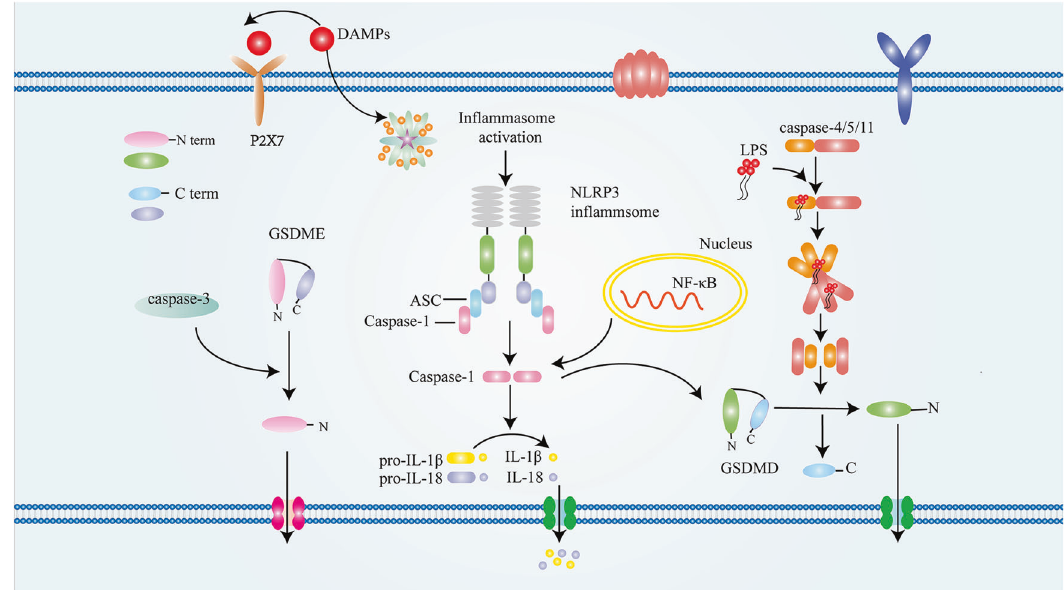
Fig. 1 The mechanism of pyroptosis. Both traditional and nontraditional mechanisms contribute to